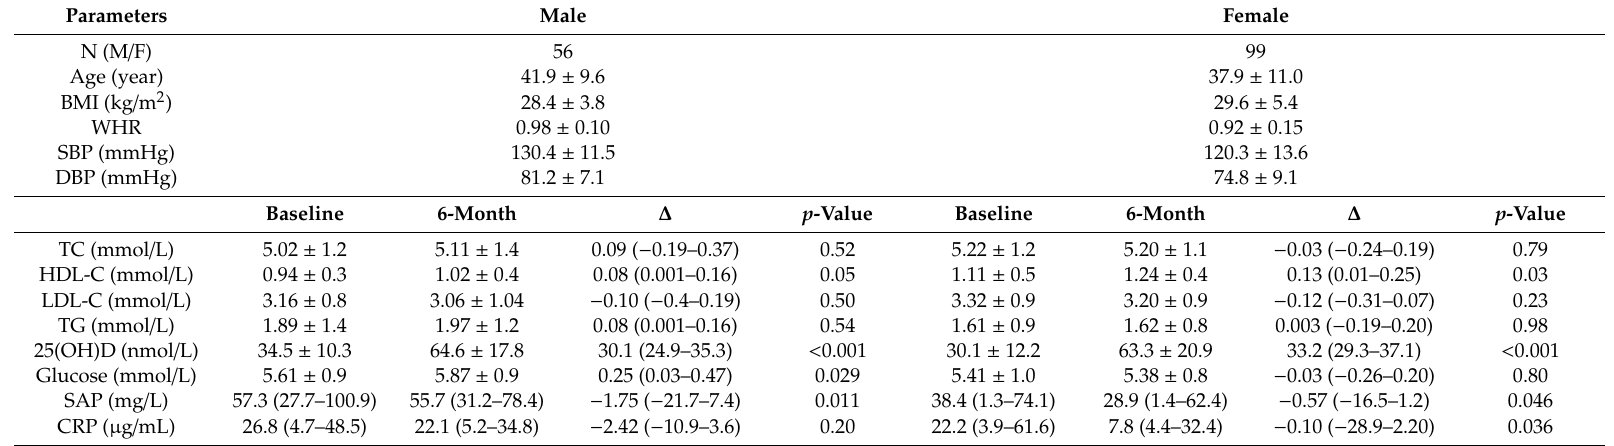
Table 3. Clinical characteristics of responders at baseline and after 6-month intervention according to sex.